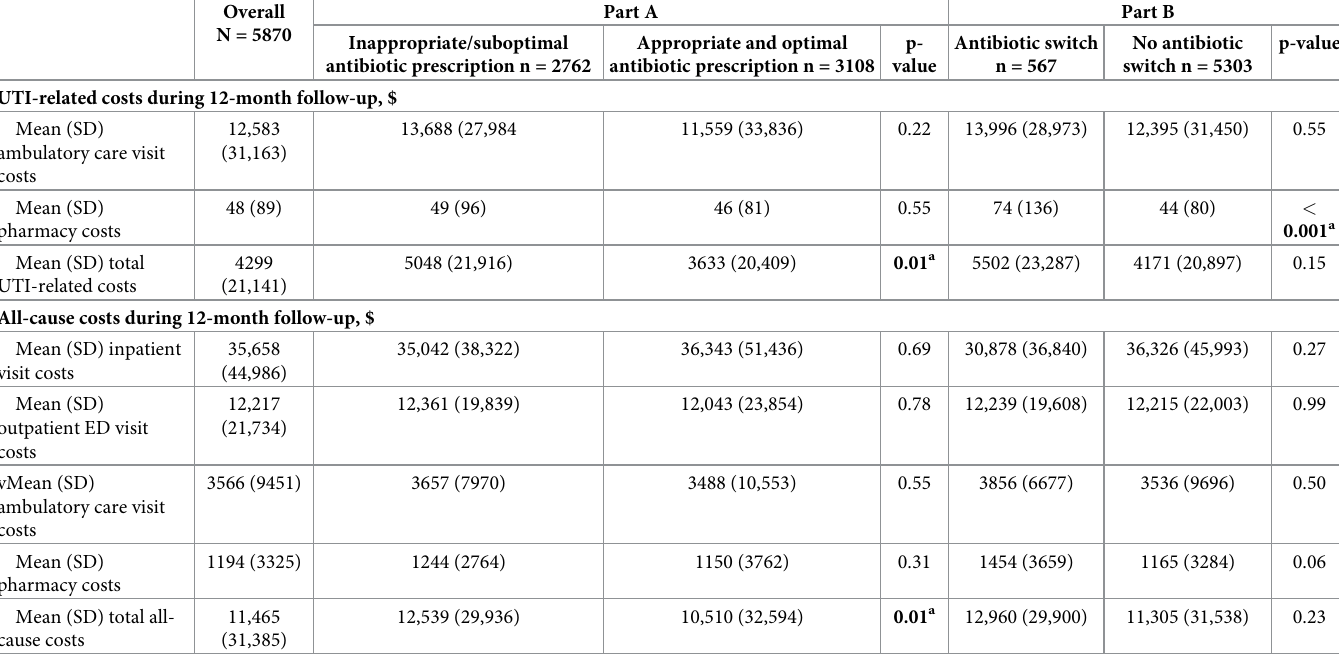
Table 5. Primary UTI-related and all-cause costs of uUTI outpatients stratified by inappropriate/suboptimal antibiotic prescription (Part A) and antibiotic switch- ing (Part B) during 12-month follow-up. Overall Part A Part B N = 5870 Inappropriate/suboptimal antibiotic prescription n =